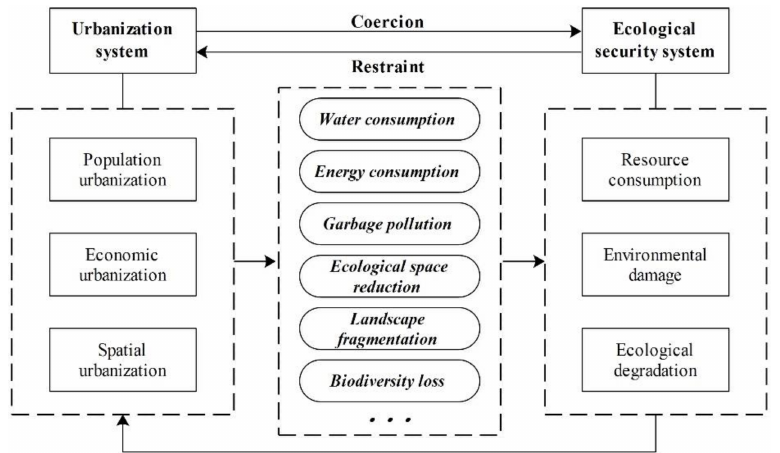
Figure 1. Interaction mechanism between urbanization and ecological